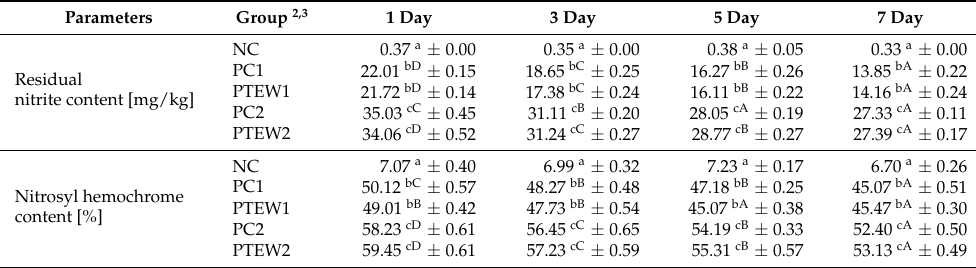
Table 3. The effect of plasma-treated egg white on residual nitrite and nitrosyl hemochrome content (mean ± SE 1 ) of liver p â t é s during storage. Parameters Group 2,3 1 Day 3